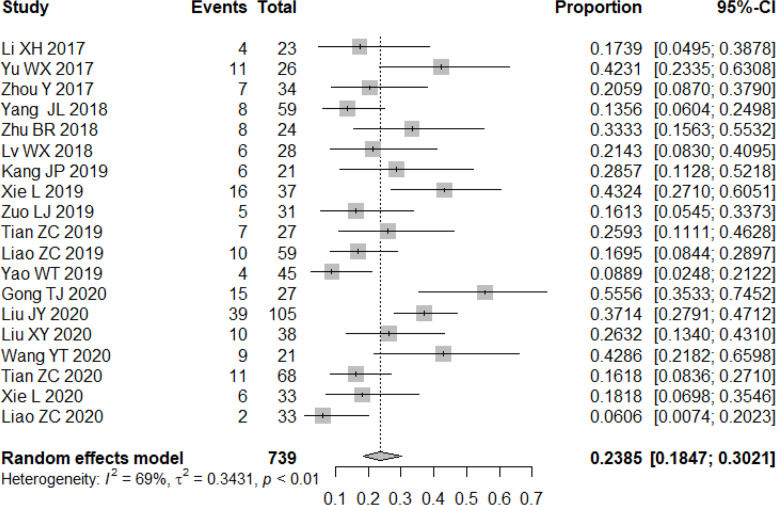
Forest plot showing the ORR of apatinib in the treatment of bone and soft tissue sarcomas.